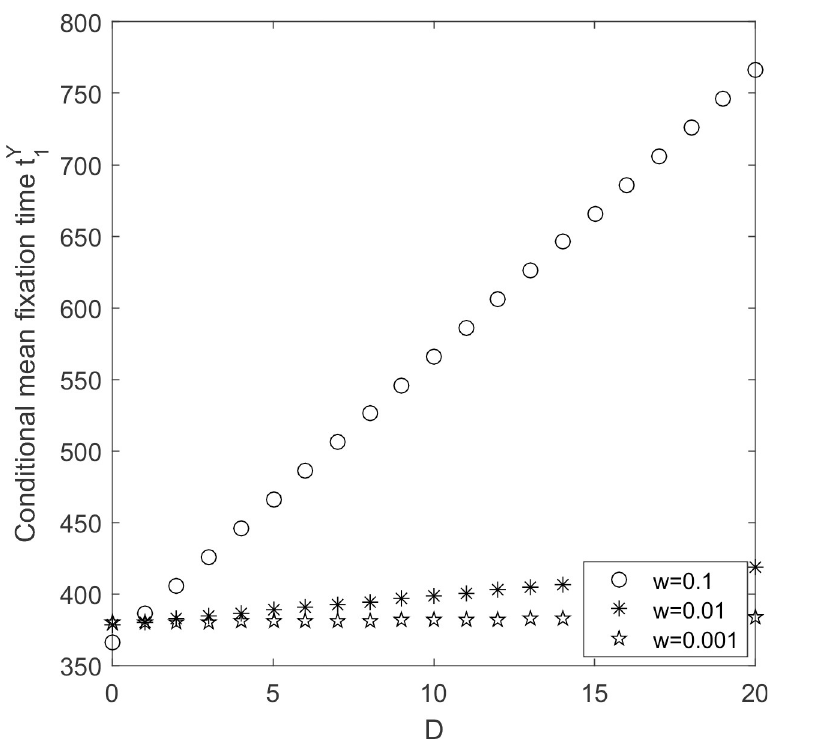
Fig 12. t Y ~ ω change 1